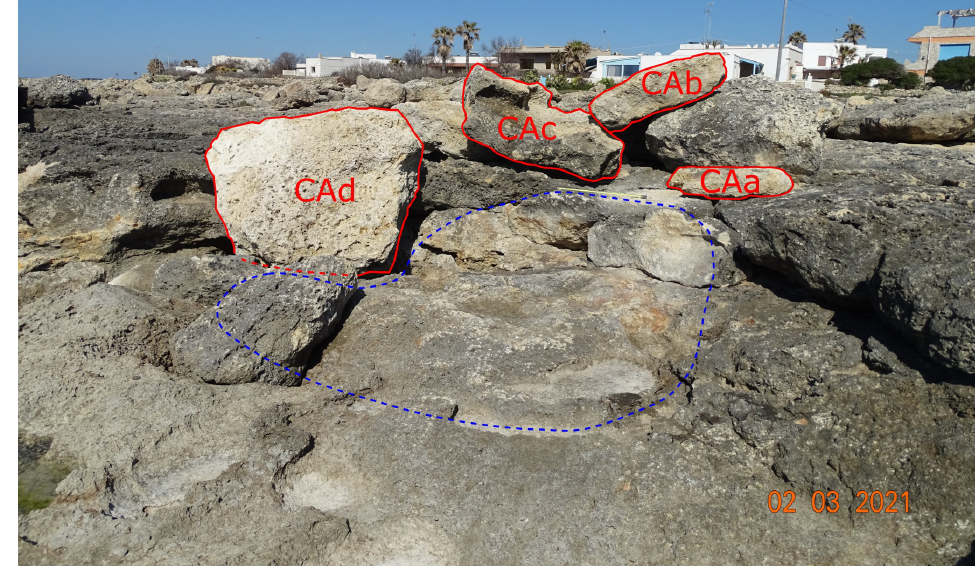
Figure A6. Capilungo coast. The boulder CAd and the group CAa,b,c taken from the coastline; the area of the initial positions is marked by the blue dashed line. Compare with Figure 9. Table A12. Main features of the displaced boulders at the Capilungo coast; see the caption of Table A2 for symbols.